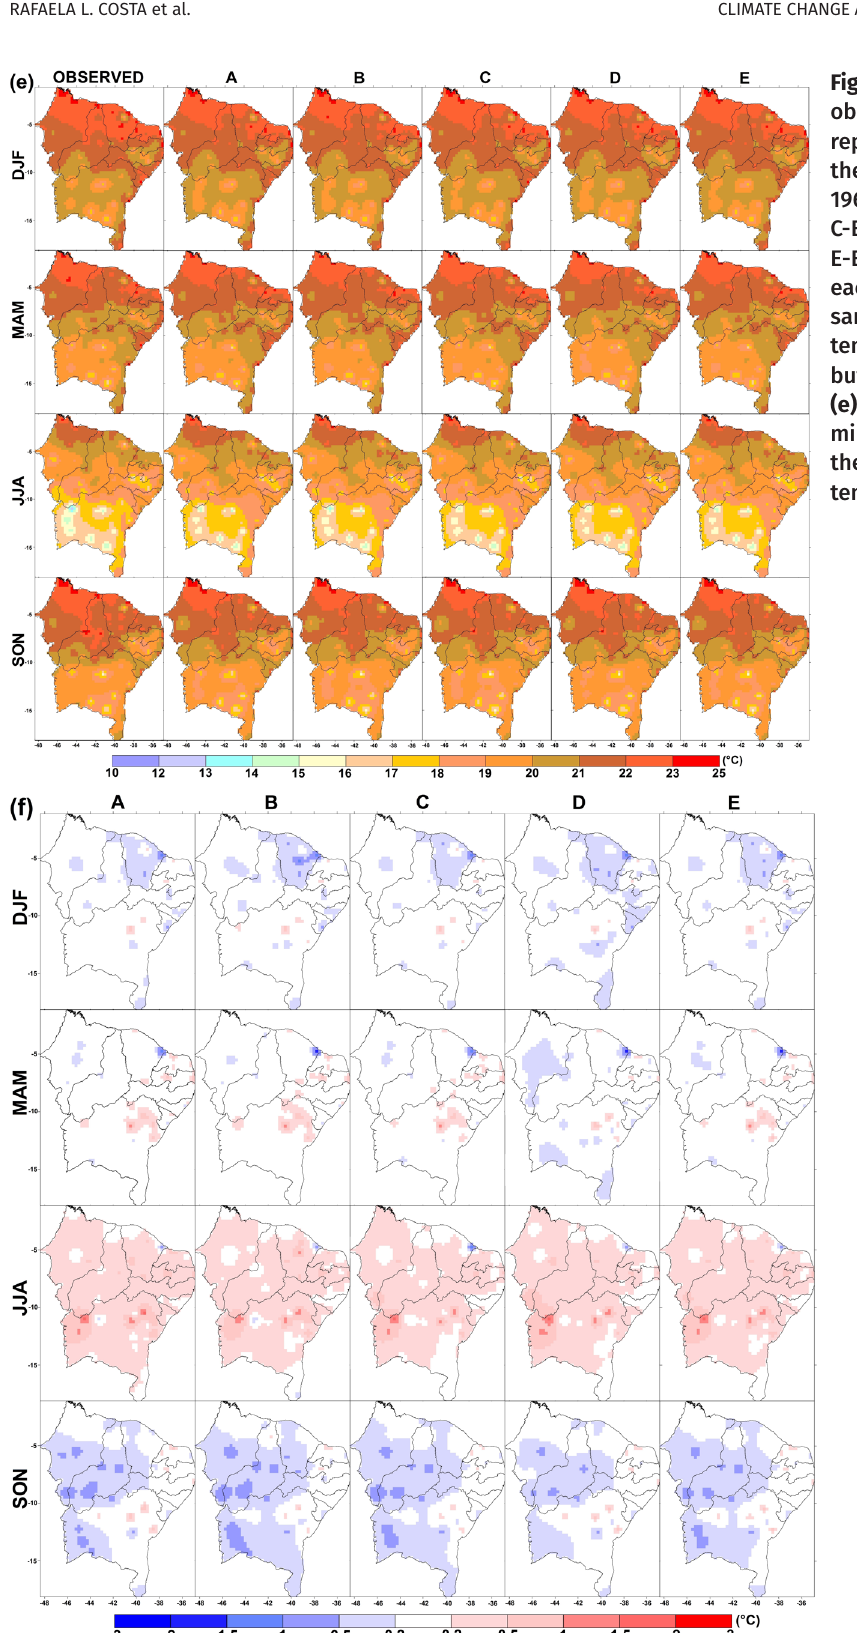
Figure 3. (a) Seasonal means of observed rainfall and the ones reproduced by each model and the ensemble for the period 1961-1990 (A-BCM2, B-CNRMCM3, C-ECHAM5-OM, D-HadGEM2-ES, E-ENSEMBLE), (b) deviations of each model for rainfall, (c) the same as a, but for maximum temperatures, (d) the same as b, but for maximum temperatures, (e) the same as a, but for minimum temperatures and (f) the same as b, but for minimum